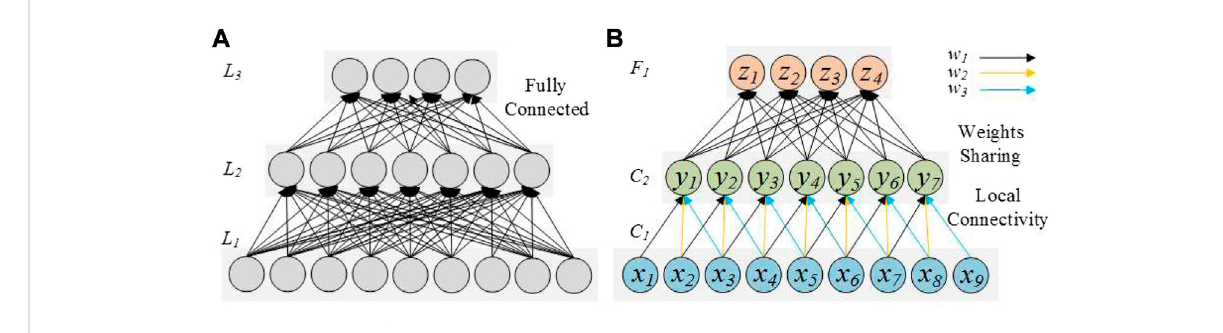
FIGURE 2 Different number of parameters generated by full connection and local connection.